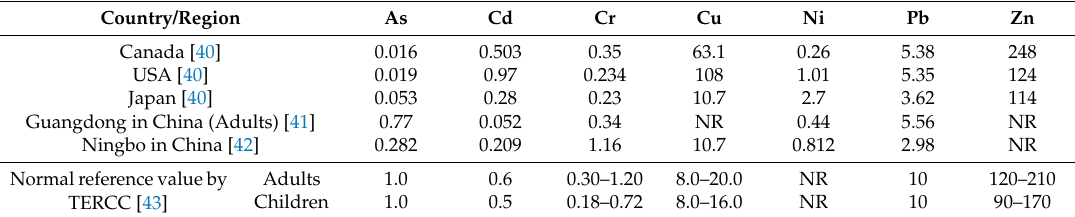
Table 4. Comparison of mean hair trace metal levels (mg · kg − 1 , dry weight) from the present study with those reported for other regions of the